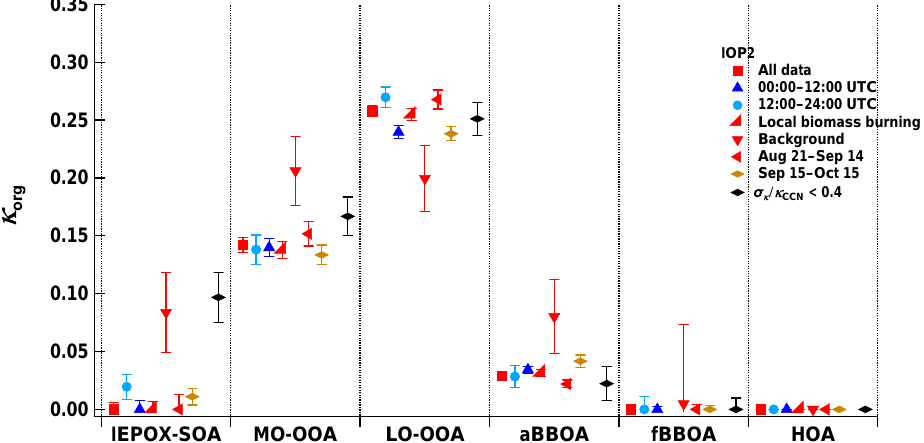
/κ CCN less than 0.6 (black diamond). CCN